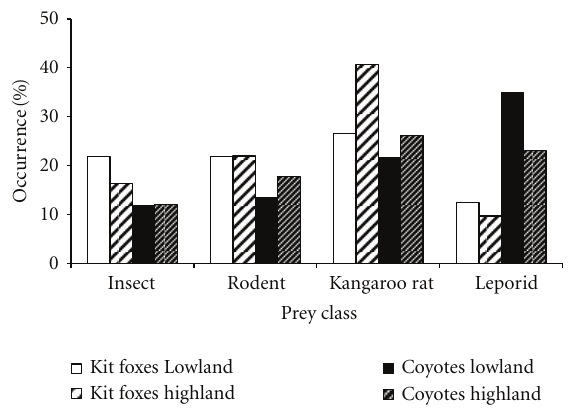
Figure 2: Percent occurrence of the top 4 prey classes found in kit fox and coyote scats and used to model predicted canid distribution, Dugway Proving Ground, Utah, 1999–2001.